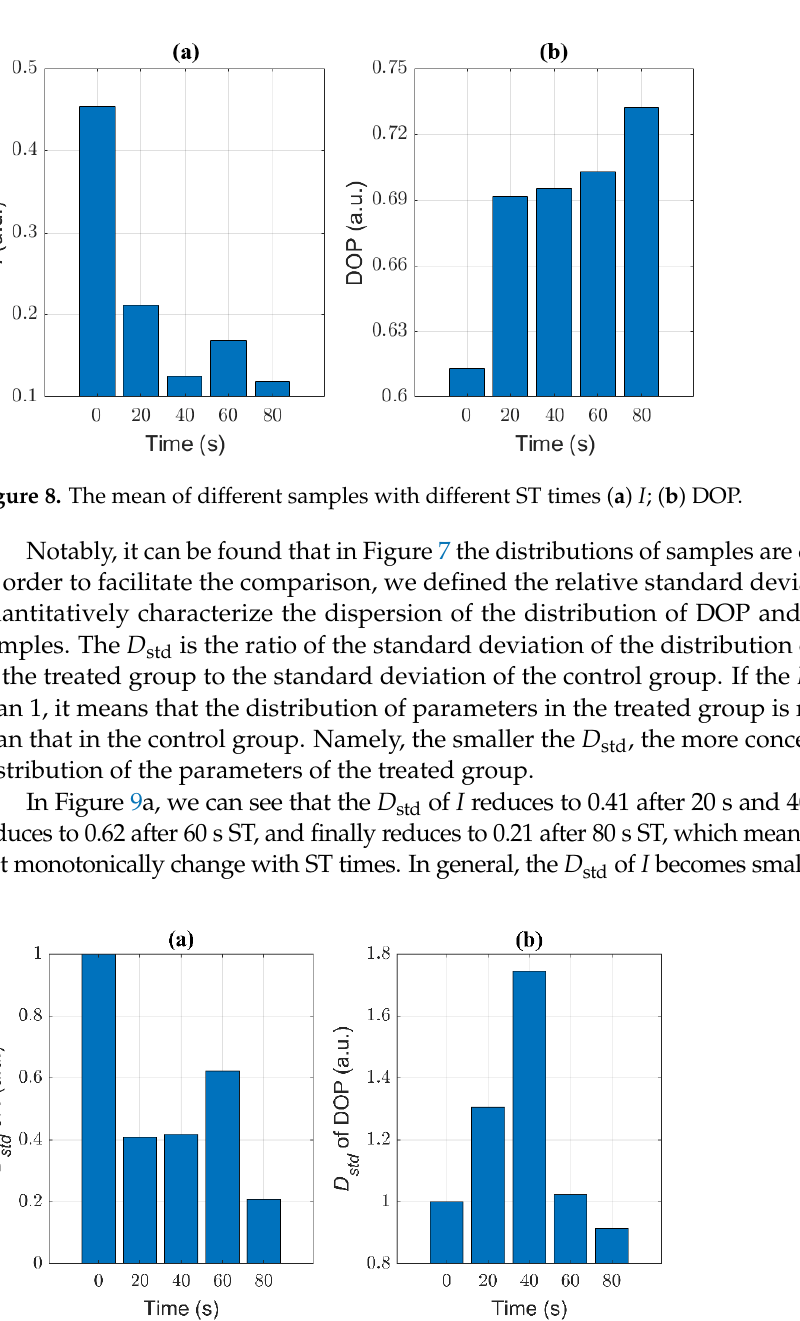
Figure 8. The mean of different samples with different ST times ( a ) I ; ( b ) DOP.